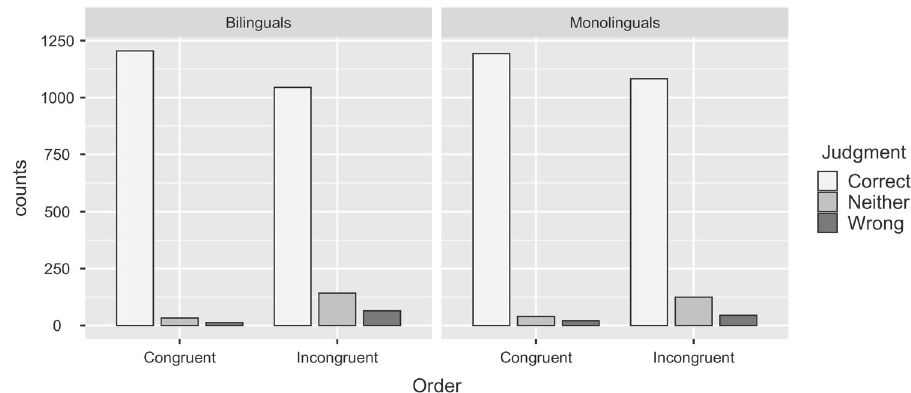
Fig. 7 Comparison of judgments across orders in two populations: monolinguals and bilinguals. The bars show raw